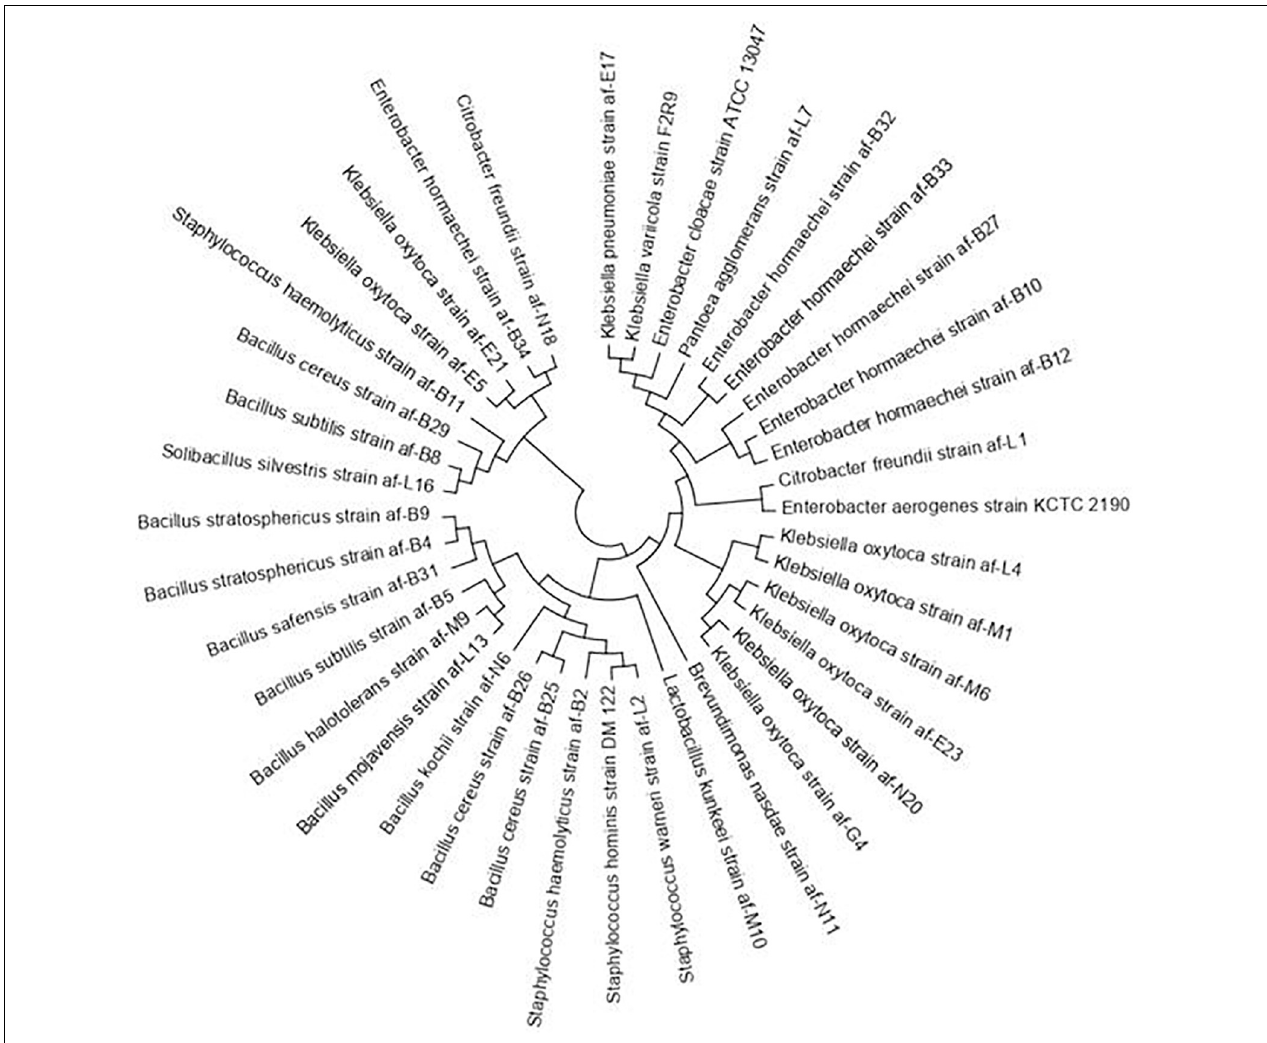
FIGURE 5 | Phylogenetic dendrogram of the 16S rRNA sequences of A. florea gut bacteria. Evolutionary analyses were conducted in MEGA6 using the maximum likelihood